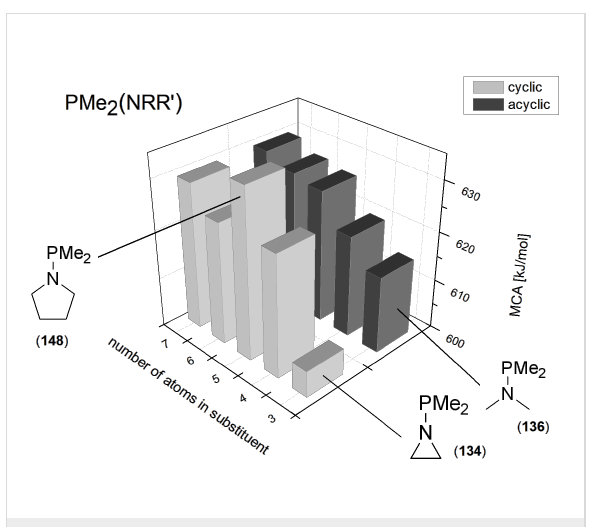
substituents show MCA values above 600 kJ/mol. In the case of saturated, acyclic substituents the trend ‘longer alkyl chains – higher MCA values’ is again observed (Figure 6). For saturated, cyclic substituents, however, the MCA values increase from aziridine ( 134 ) to azetidine ( 140 ) and pyrrolidine ( 148 ), but then decrease again for piperidine ( 139 ) and azepane ( 145